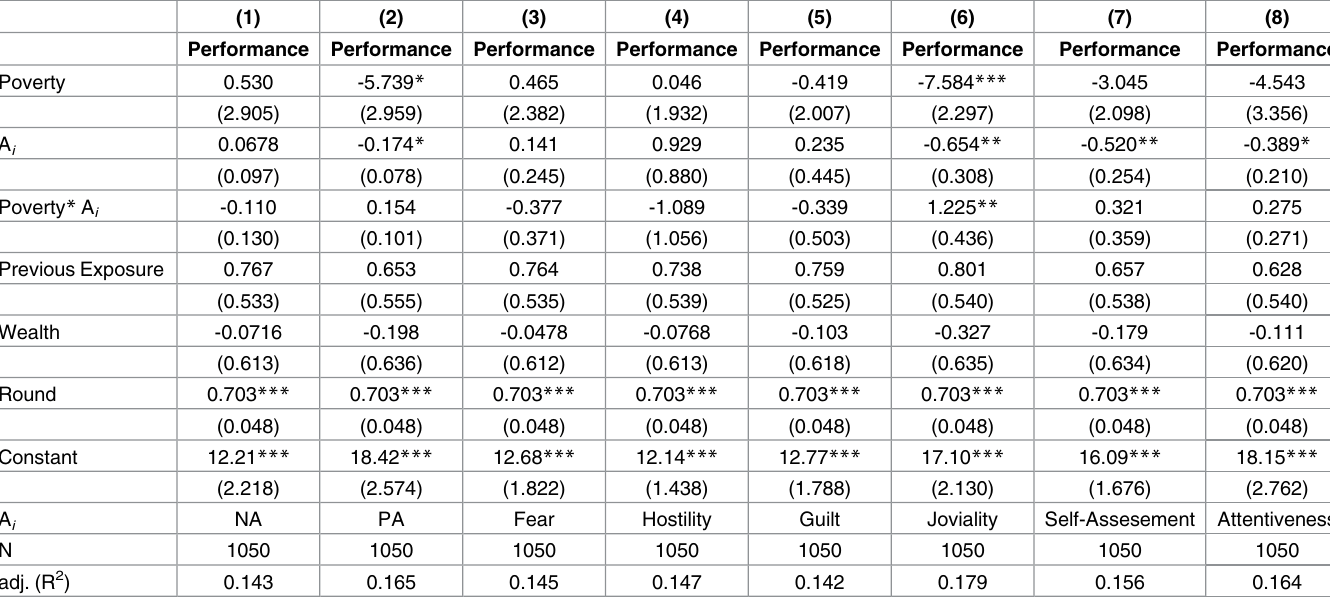
Table 5. Moderation Analysis, Self-Reported